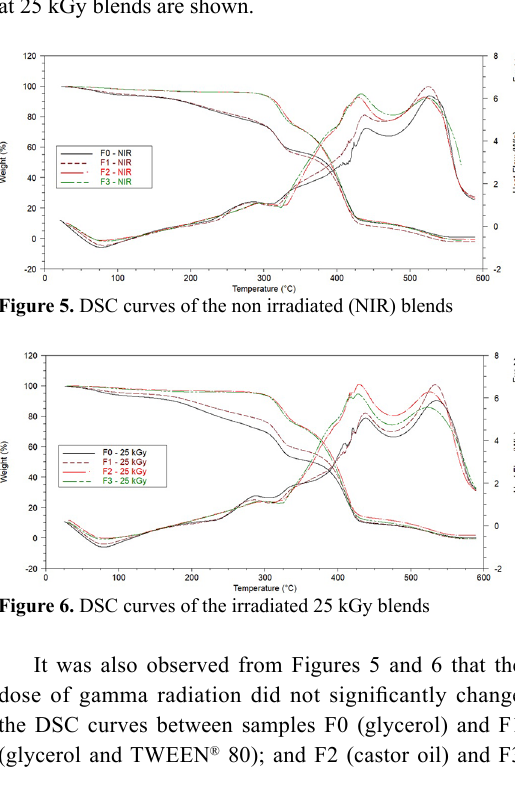
at 25 kGy blends are shown.